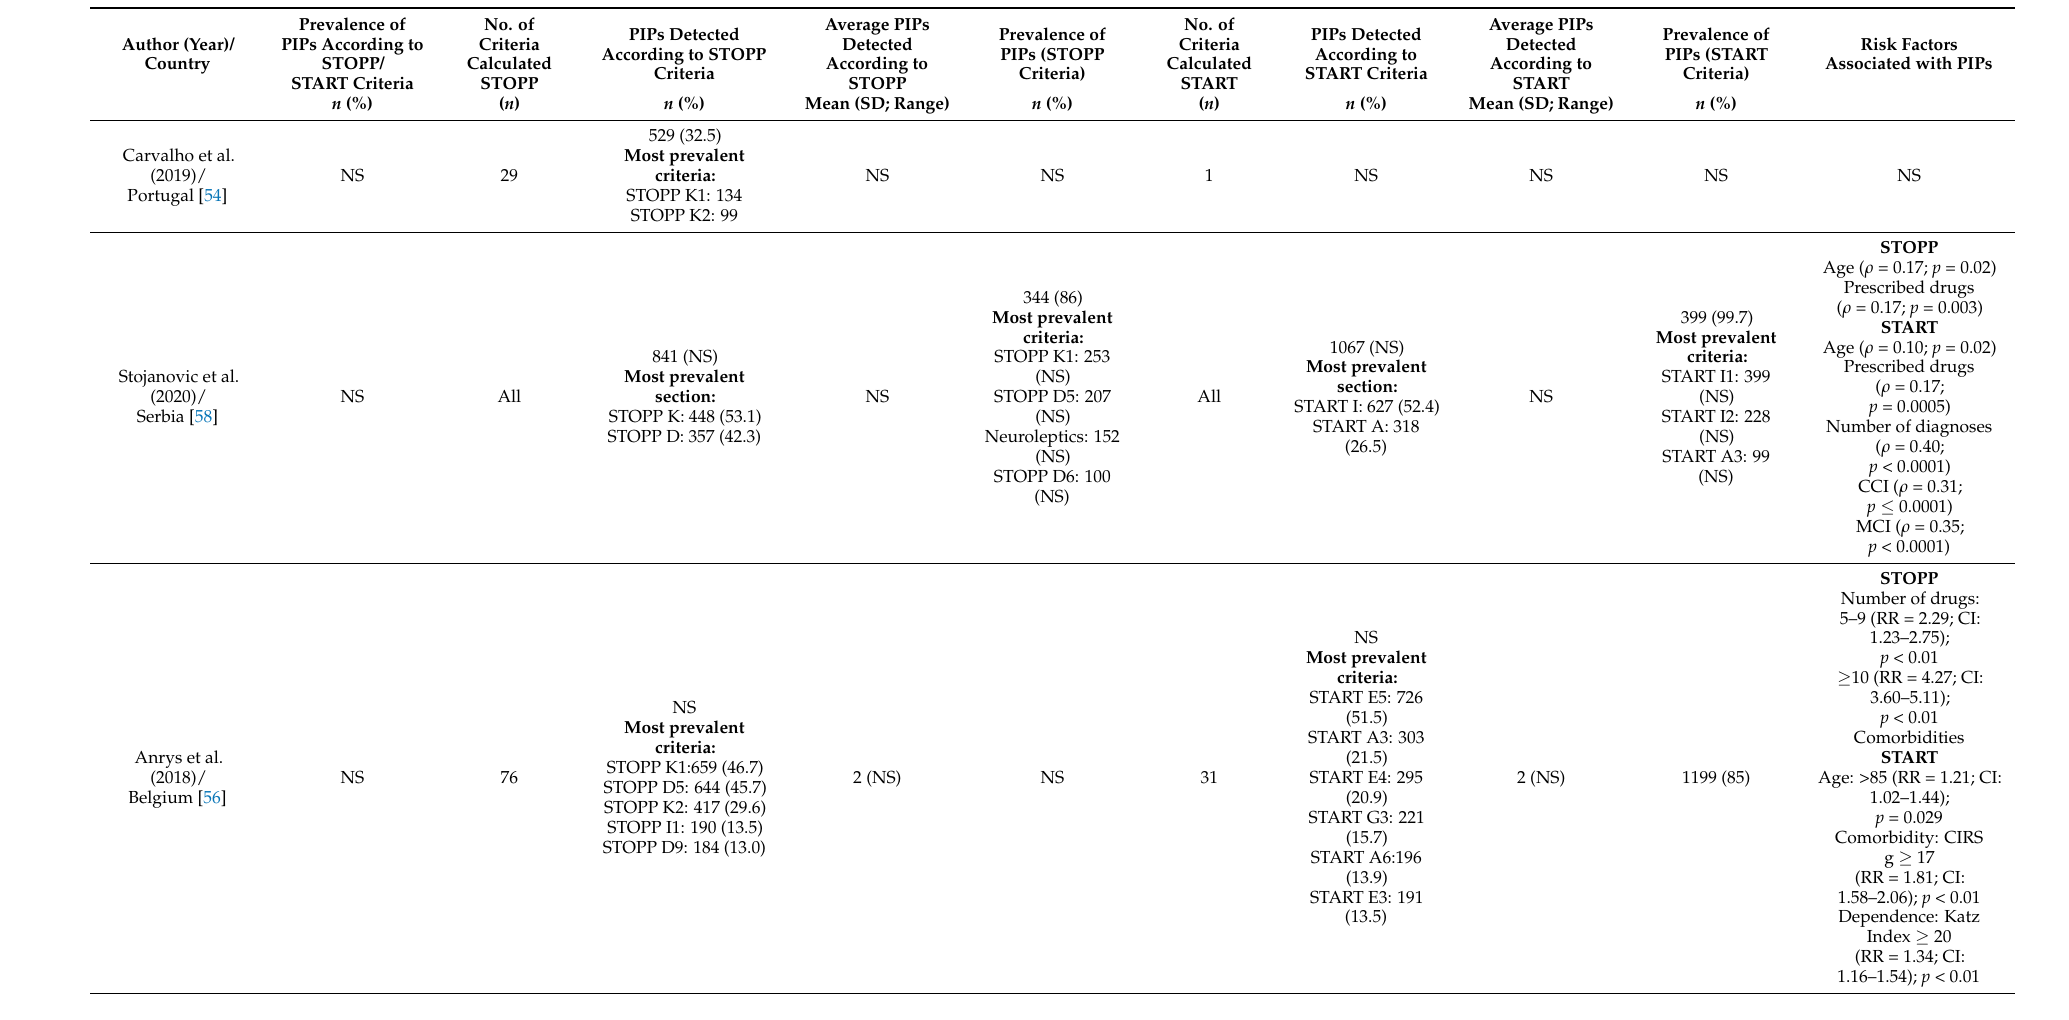
Table 3. Summary of the main results of potentially inappropriate prescriptions in the resident population of